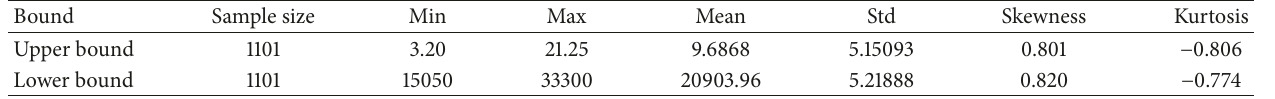
Table 2: The statistical description of the interval-valued carbon future prices.